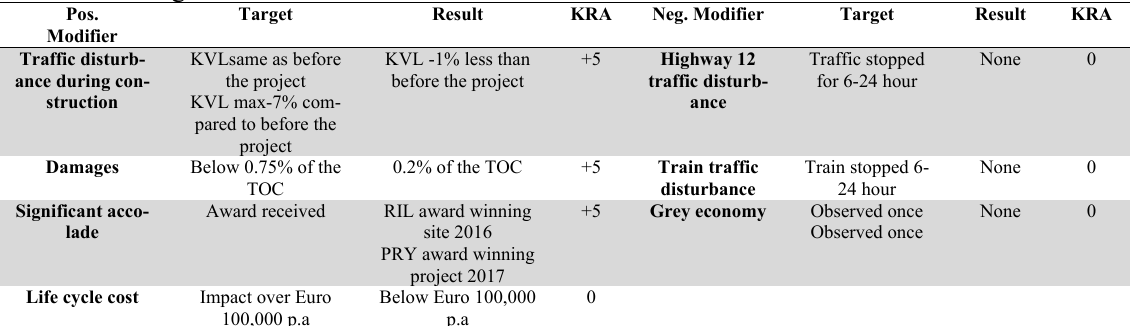
Positive and negative modifiers for